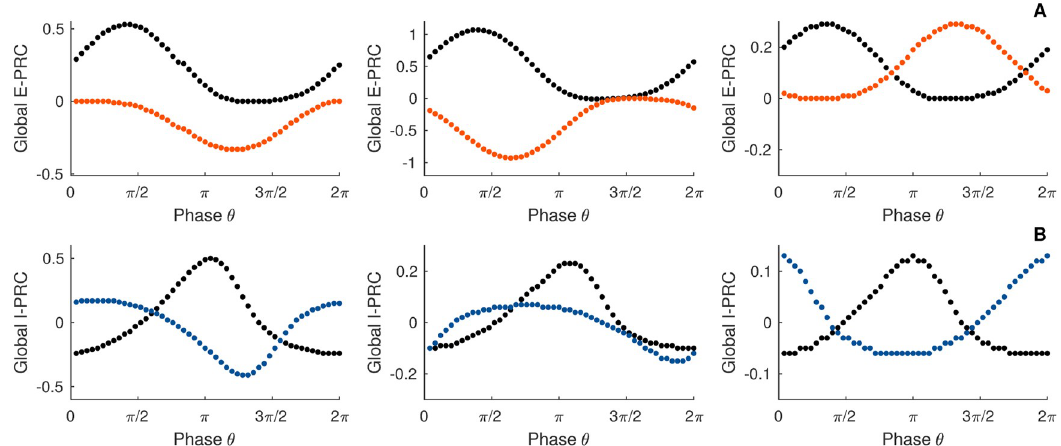
Fig 9. Global PRC and emerging directionality. Black dots illustrate direct perturbations of the leader, color dots indicate direct perturbations of the follower. A) Perturbations are made on the E-cells. B) Perturbations are made on the I-cells. Parameters: N = 5000; τ e = τ i = 10; τ se = τ si = 1; � Z ¼ � Z ¼ (cid:0) 5 ; J ee = 0; J ei = 15; J ii = 0; J ie = 15; I ext e i 0.5; direct perturbations are made with a square wave current pulse (amplitude 1, duration 0.1), the first panels d = 6, the second panel d = 7, the third panel d =